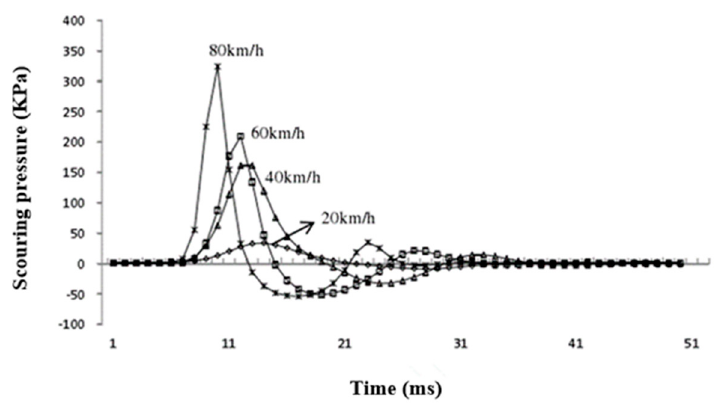
Figure 5. The variation of scouring pressure with time at different speeds.